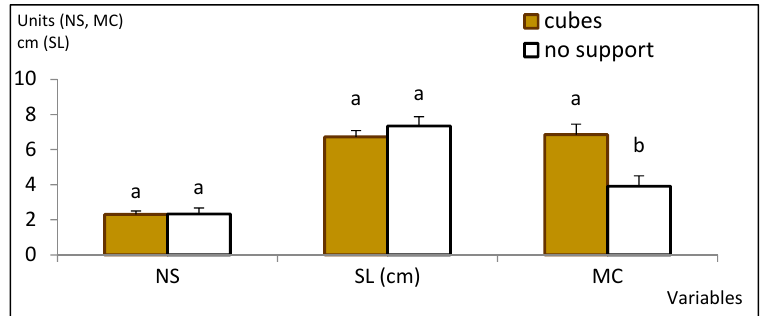
Figure 2. Effect of support material on proliferation rates of willow shoots grown in continuous immersion bioreactors. Shoots were grown in MS medium with half-strength nitrates, 0.22 µM BA and 3% sucrose for 8 weeks. Values are presented as mean ± standard error (3 replicates with 20 explants each). For each variable, different letters indicate significant differences at p < 0.05. NS. number of shoots; SL, length of the longest shoot; MC, multiplication coefficient. In next experiment, we compared two sucrose supplementations (S0 and S3, corre- sponding to 0 and 3% sucrose, respectively) and two types of support: rockwool cubes and plastic boxes with holes, which were pipette tip boxes (Figure 1d). Sucrose did not affect the number of shoots (NS) or the shoot length (SL), regardless the support ( p = 0.202 and 0.216, respectively) or MC for explants cultured with cubes, whereas those cul- tured in boxes proliferated more without sucrose (Figure 3, Table S2). The choice of sup- port had a significant effect ( p = 0.029 for NS and p < 0.001 for SL and MC), and higher values were obtained when plastic boxes were used. In contrast, the photosynthetic pigments were more affected by the sucrose and the interaction of sucrose × support than by the support itself (Figure 4, Table S3). For sucrose, p values were lower than 0.001 for all parameters, similarly to the interaction of sucrose × support (lower than 0.006), whereas for support, p values of 0.851, 0.446 and 0.736 were obtained for chloro- phyll a and b and total carotenoids, respectively. Among the shoots cultured with plastic boxes, more pigments were observed when shoots were cultured in S0, whereas no sig- nificant differences were detected between S0 and S3 in the case of the cubes.